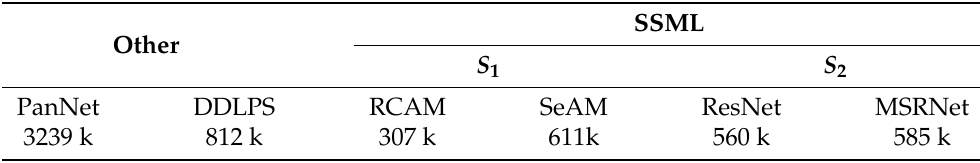
Table 9. The number of parameters of different deep-learning